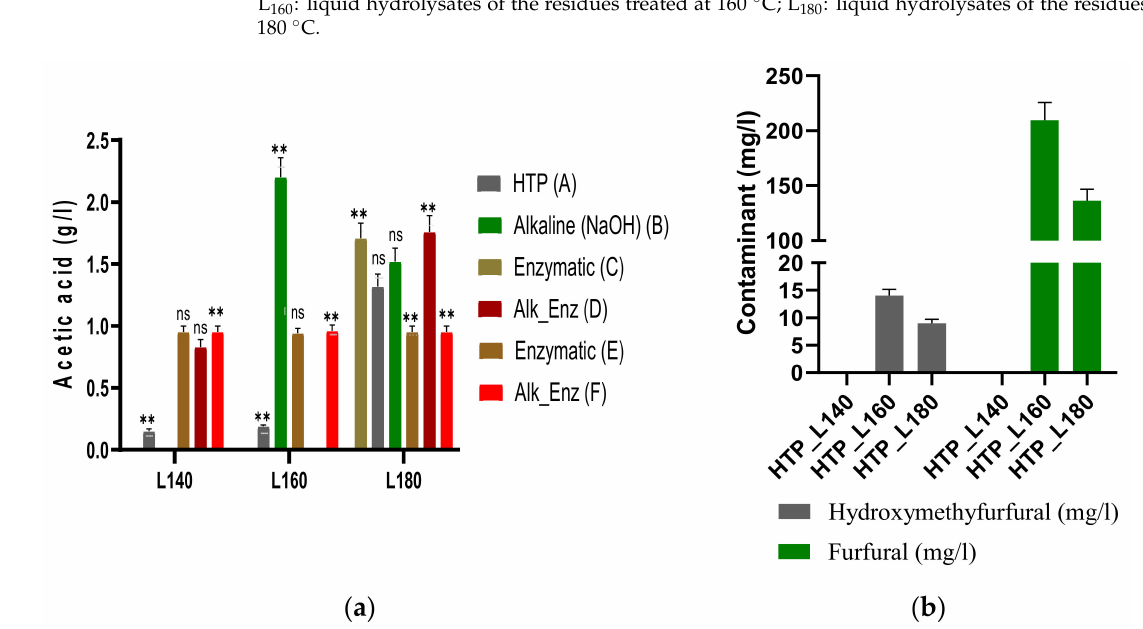
Figure 2. ( a ) Yield of acetic acid (g/L) detected in the hydrolysates after HTP, alkaline and enzymatic treatments of the solid residues; ns: not statistically significant; ** Correlation is significant at the 0.05 level (2-tailed); ( b ) Yield of furfural and HMF (mg/L) detected in the hydrolysates after HTP